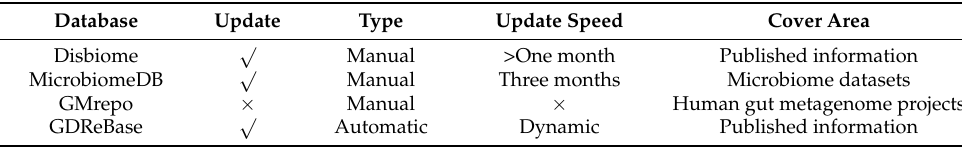
Table 1. Comparison with other databases.